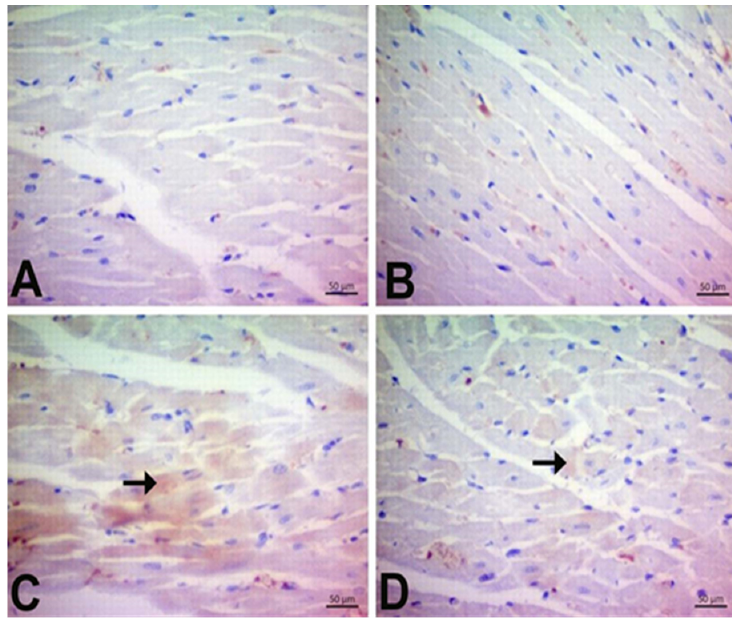
Figure 9. Immunohistochemical staining of 8-OHdG in experimental groups in cardiac tissue (×400). The 8-OHdG expression levels were signi fi cantly elevated in DOX-treated rats, while CGA-treated rats demonstrated a signi fi cant decline in 8-OHdG expression. Arrowhead: Intensity of immunoreactivity. ( A ) Control ( B ) CGA ( C ) DOX ( D ) DOX + CGA. Data are presented as the means ± SD. CGA: Chlorogenic acid (100 mg/kg); DOX: Doxorubicin (15 mg/kg).